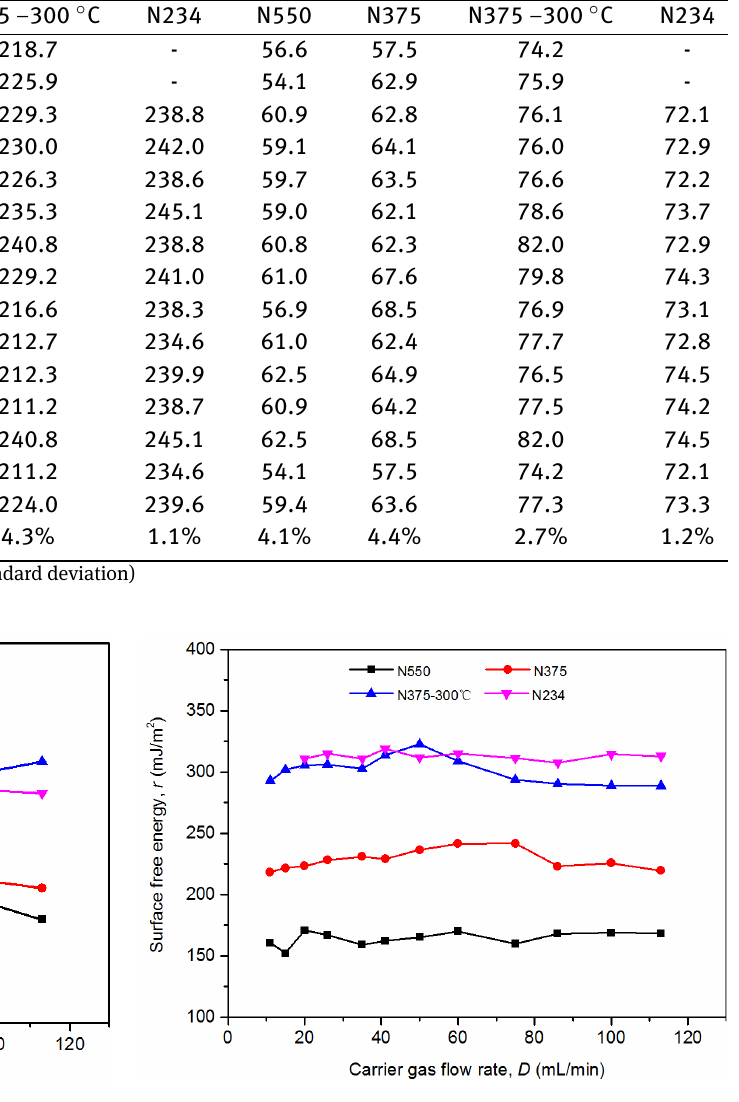
Figure 11: Surface free energy of different samples versus carrier gas flow rate lar parameter of CB is not significant. According to the data of N375 and N375-300 ∘ C, we know both dispersive free en- ergy and polar parameter of N375 CB after 300 ∘ C treatment have a significant increase of about 36% compared with the results from untreated CB, which indicates that the sur- face free energy of CB will change after heating. However, no matter the CBs have been heated or not, the effect of car- rier gas flow rate on the experimental results is not signif- icant when the surface free energy is measured by inverse gas